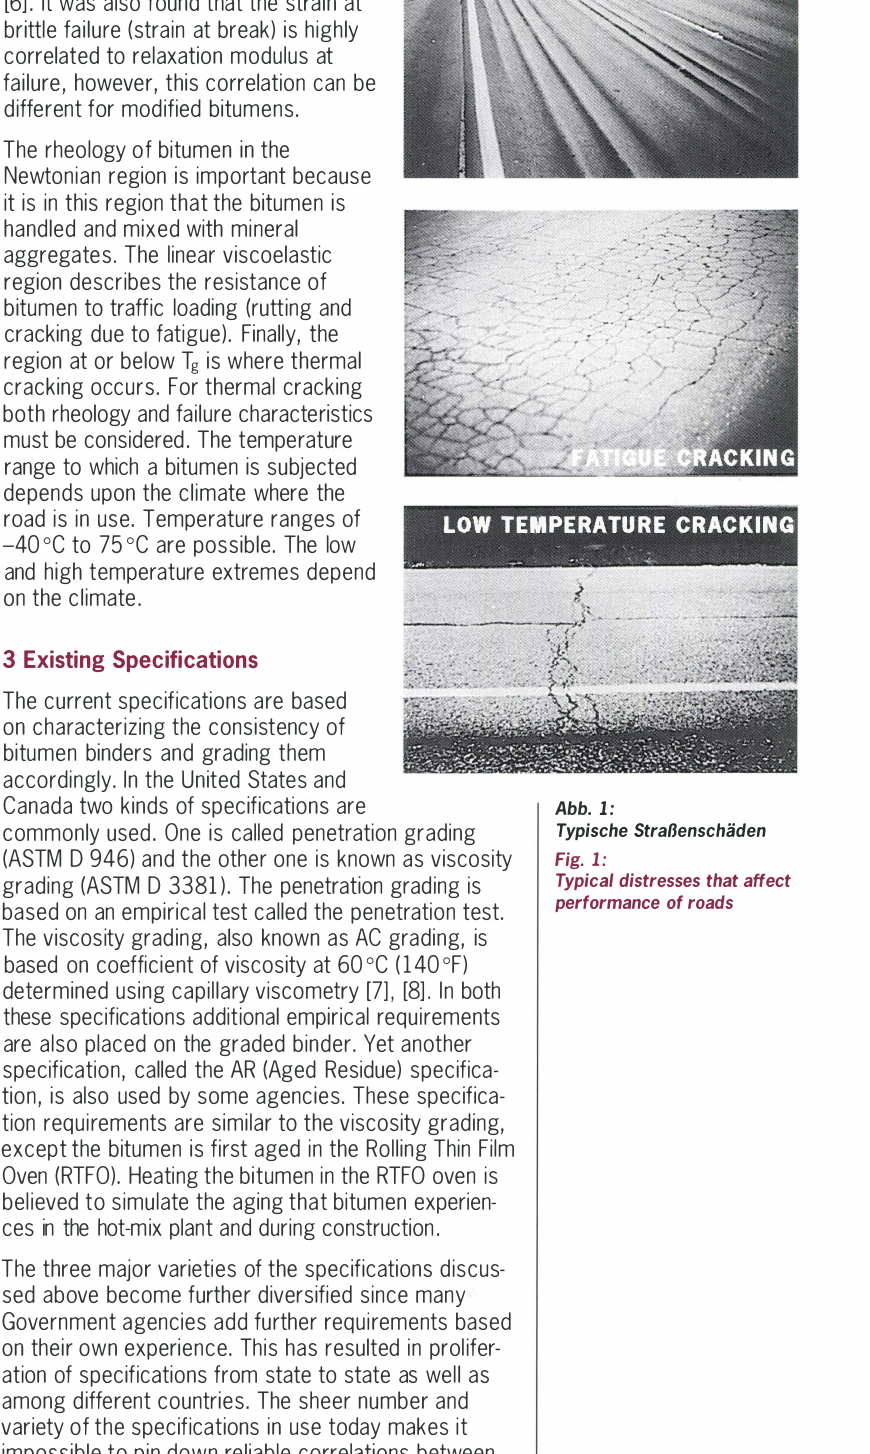
Fig. 1: Typical distresses that affect performance of